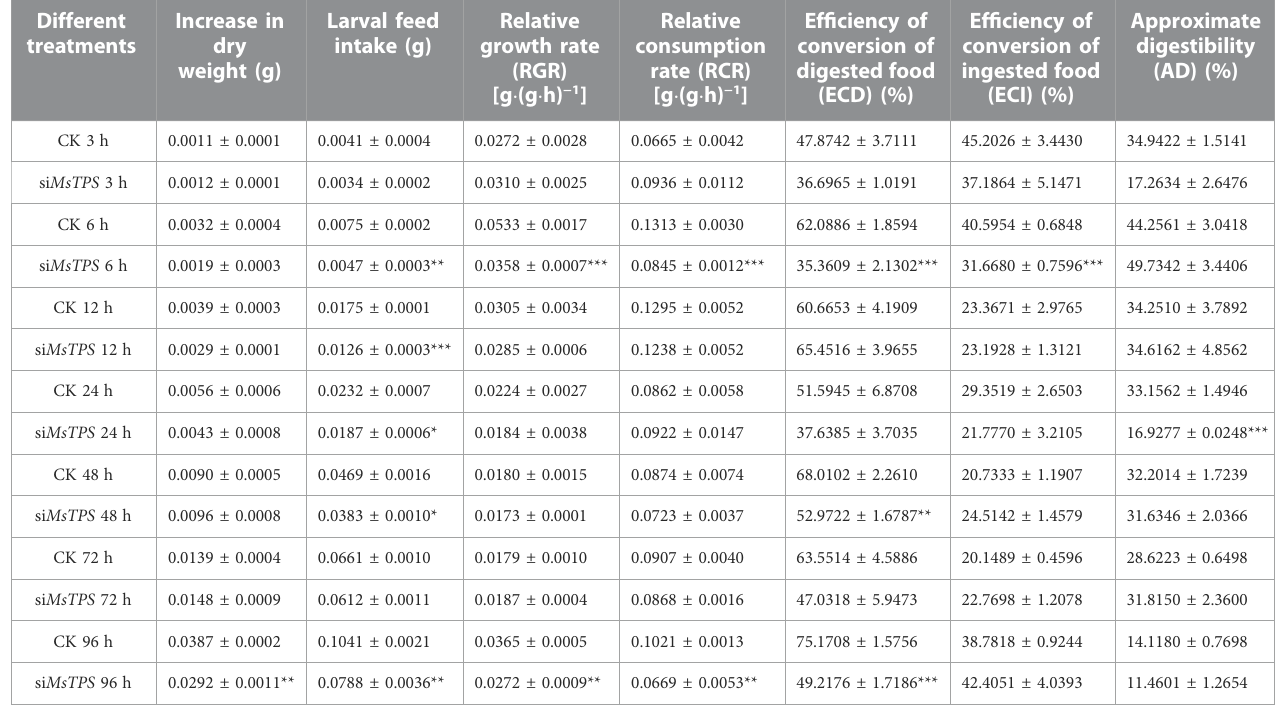
TABLE 1 Nutritional indices for M. separata at different time-points after the silencing of MsTPS by RNA interference. Different treatments